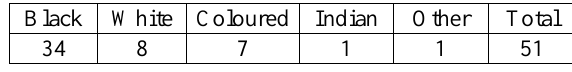
Table 4: The racial grouping of learners Black White Coloured